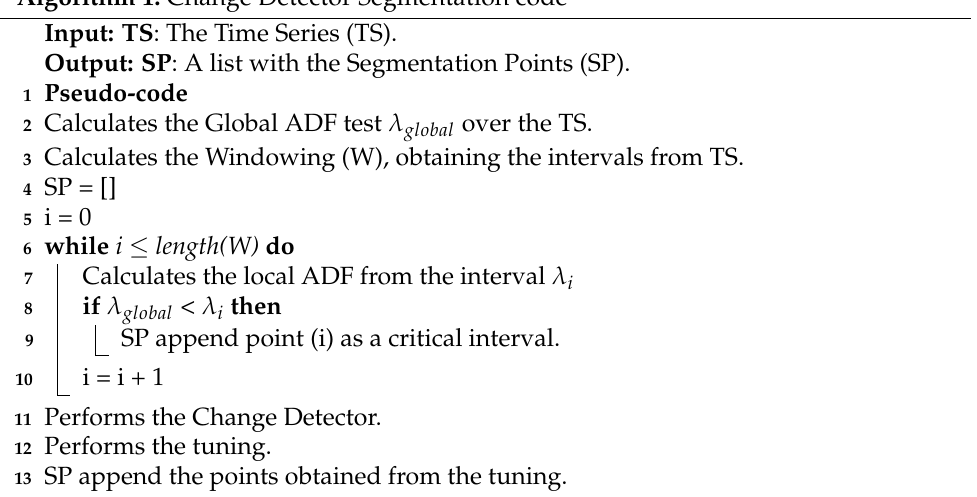
Algorithm 1: Change Detector Segmentation